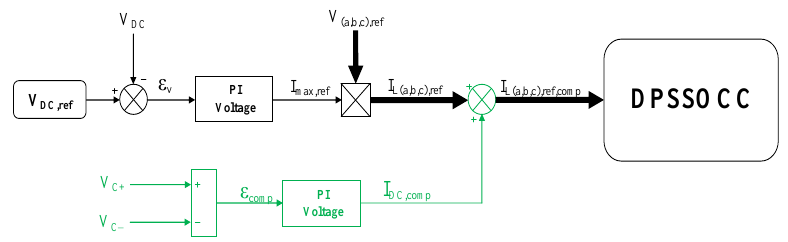
Figure 4. Synoptic of the imbalance voltage compensation loop.